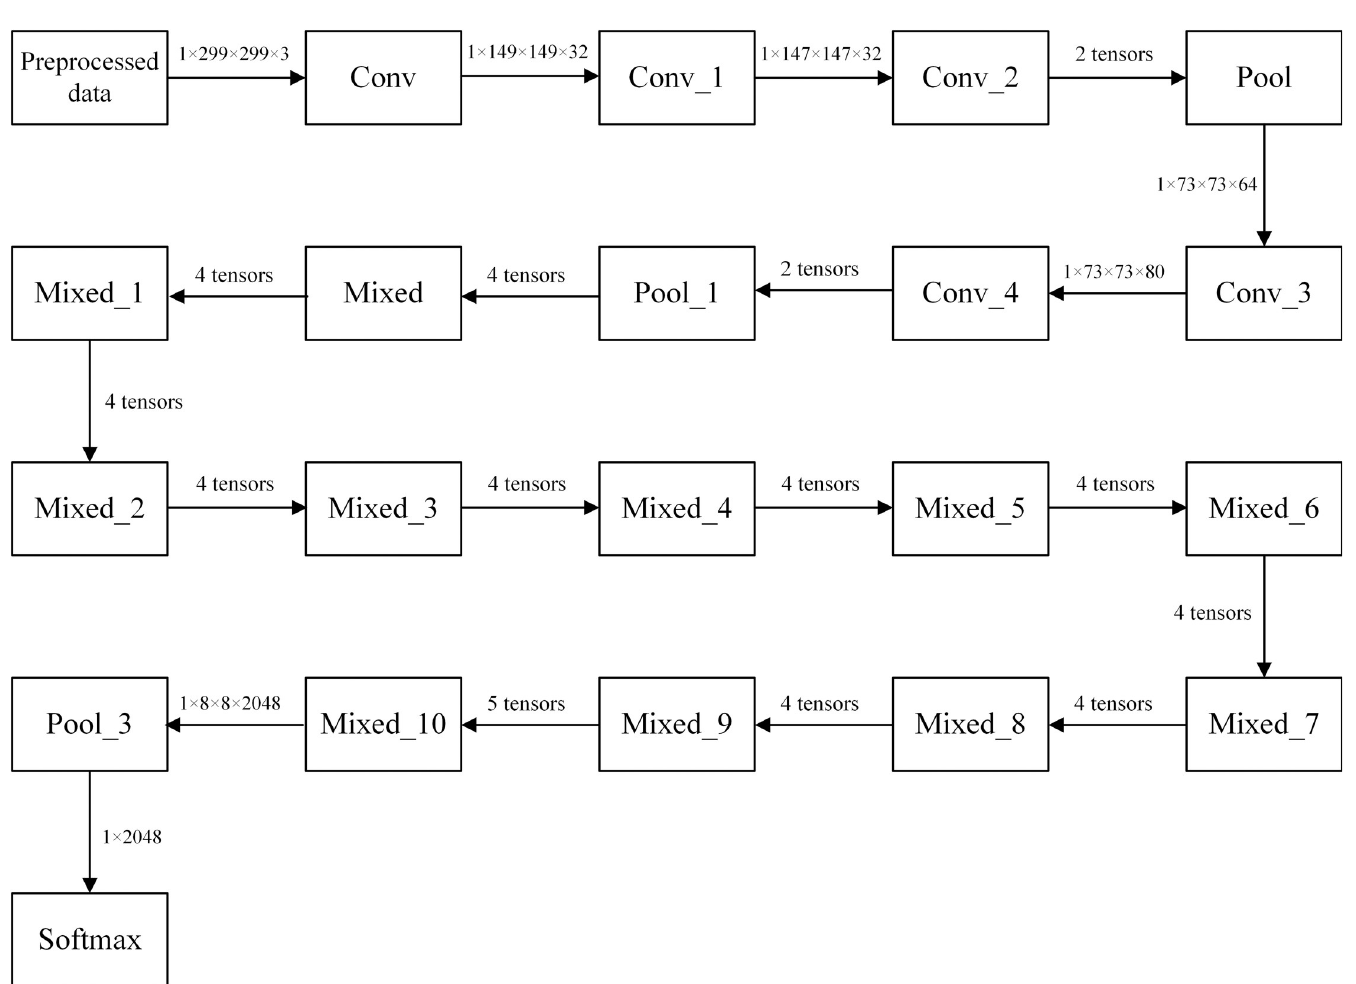
Fig 1. InceptionNet-V3 model architecture